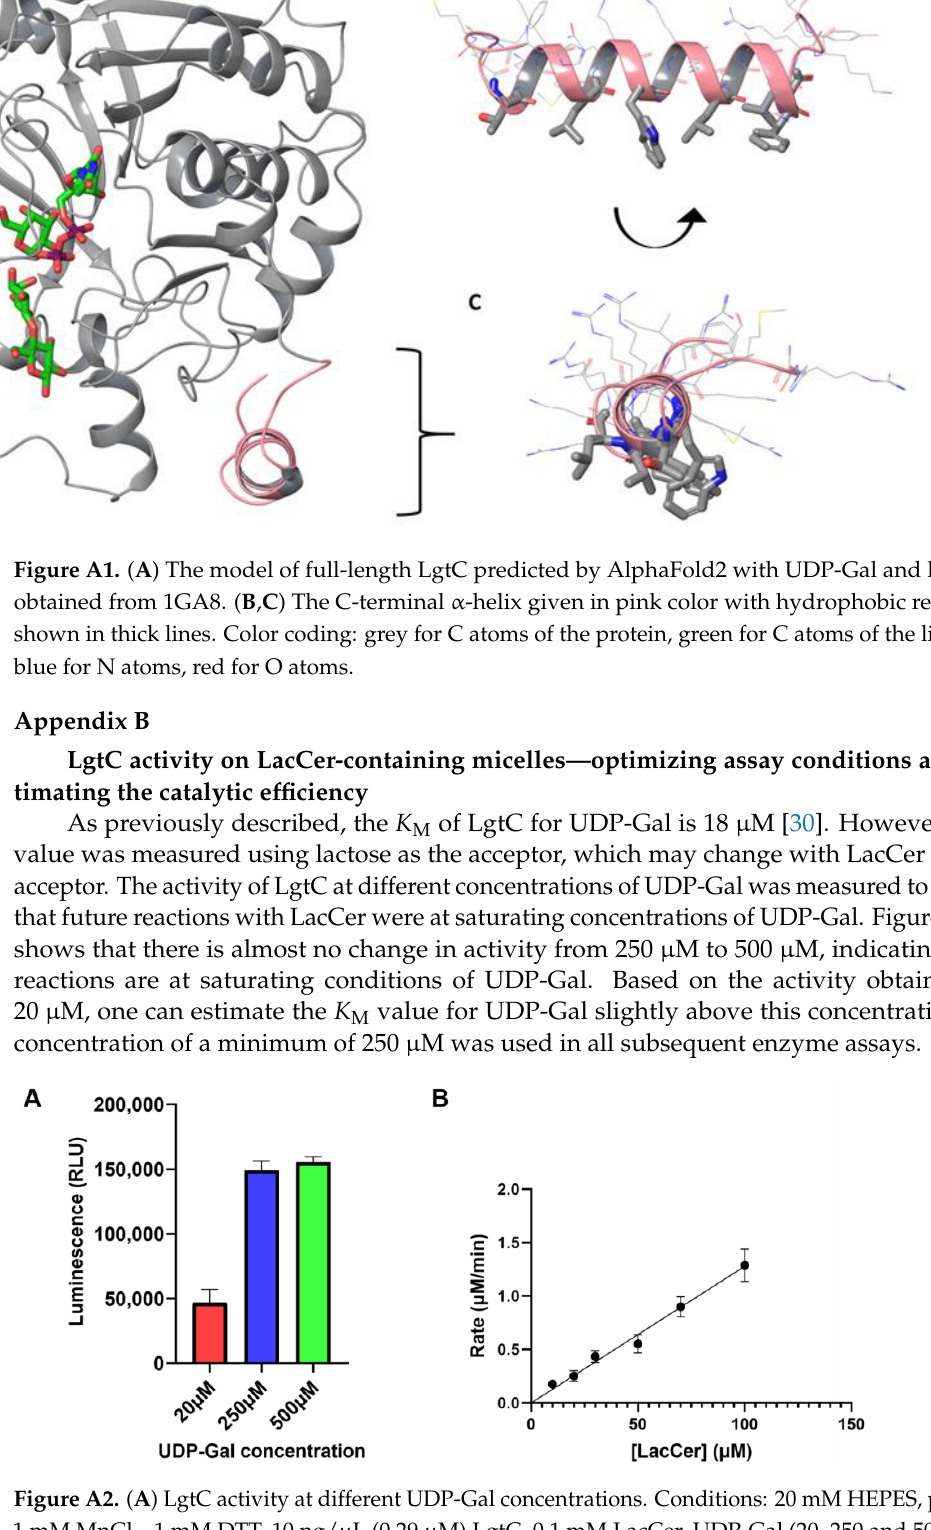
Figure A2. ( A ) LgtC activity at different UDP-Gal concentrations. Conditions: 20 mM HEPES, pH 7.4, 1 mM MnCl 2 , 1 mM DTT, 10 ng/ μ L (0.29 μ M) LgtC, 0.1 mM LacCer, UDP-Gal (20, 250 and 500 ( B ) LgtC activity at different LacCer concentrations. The solid line represents the best fit to the simplified Michaelis–Menten equation, yielding k cat [ E ]/ K M = 0.0128 min − 1 . Conditions: 10 ng/ µ L LgtC, 0.25 mM